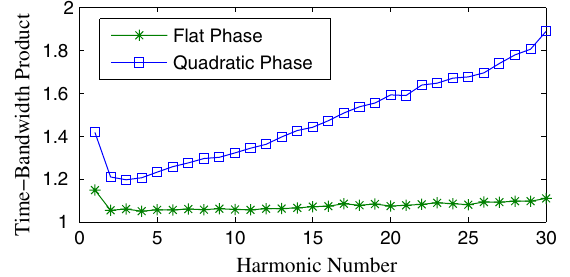
FIG. 11. The rms TBP vs harmonic number for the pulse parameters given in Table I. Even for this nearly transform- limited seed pulse, the TBP at the 30th harmonic (blue squares) is almost 3 times the transform-limited flat-phase case (green